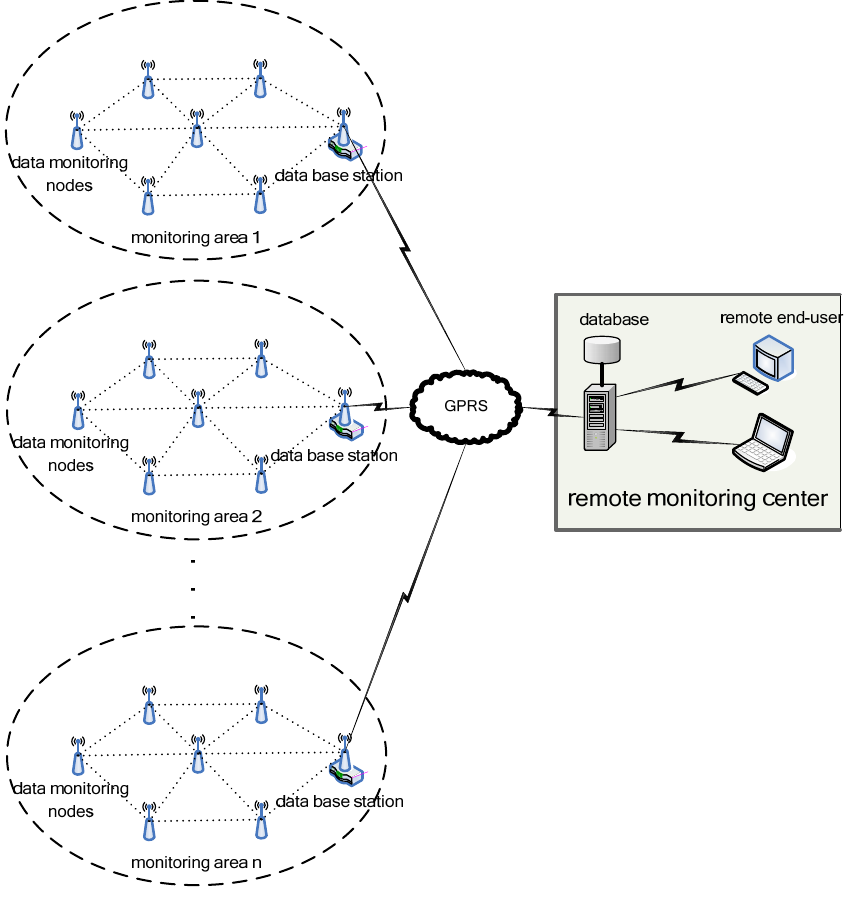
Figure 1. Water environment monitoring system based on WSNs.